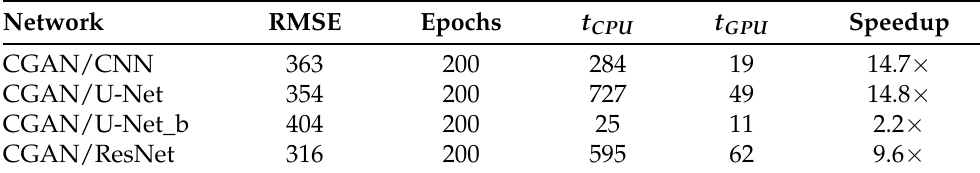
Table 4. Reconstruction error (RSME), epochs, CPU and GPU execution times in minutes and speedup as the fraction t CPU / t GPU for the training of the CGAN using CNN, U-Net, U-Net_b [20,36], and ResNet as generators for multispectral reconstruction. Networks with lower RSME provide better results.